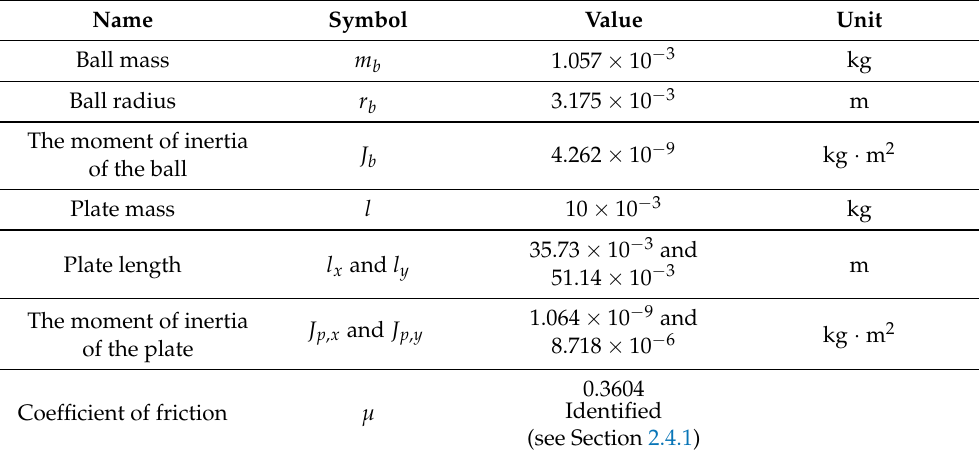
Table 1. The definition of variables and